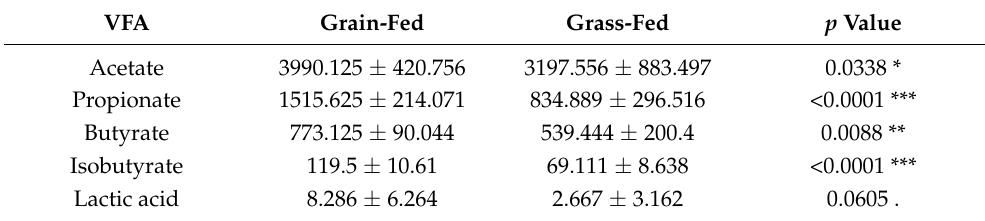
Table 1. Analysis of VFA and lactate levels between grass-fed and grain-fed rumen. Concentration unit is shown as parts per million (ppm).